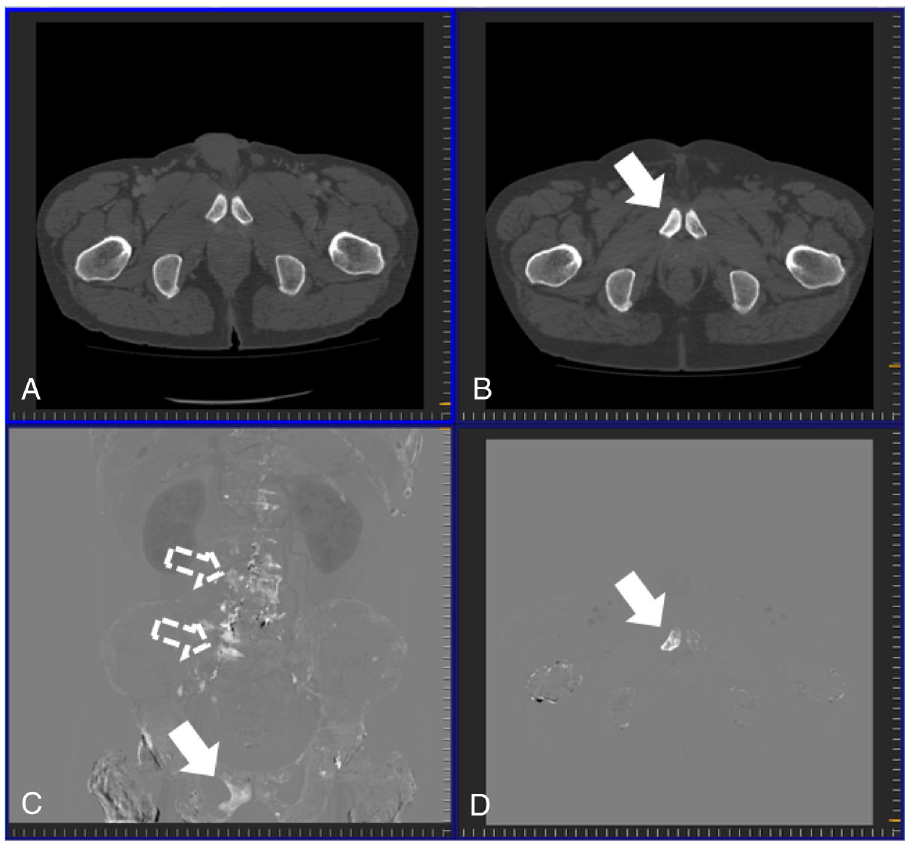
Figure 5. Osteogenic metastasis in the right pubis (arrow) accompanied by degenerative changes (outlined arrow) in a 59-year-old male patient with prostate cancer. ( A ) Previous computed tomography (CT) image; ( B ) current CT image; ( C ) temporal subtraction (TS) image; ( D ) projection image of TS